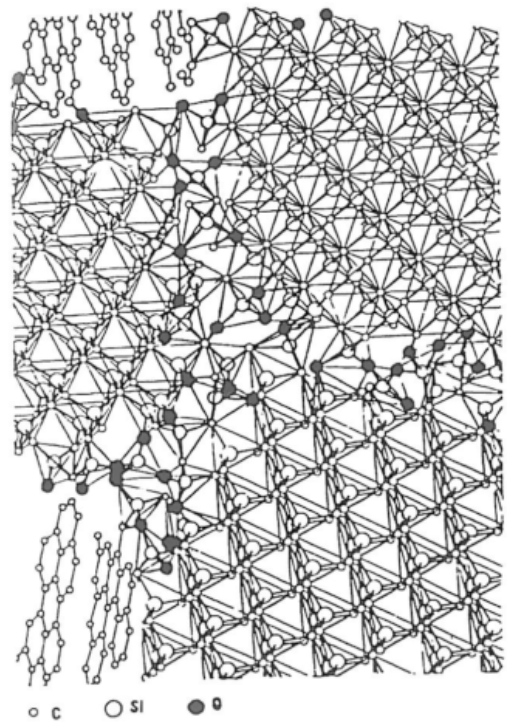
Figure 40. Texture model of the Nicalon NLM-202 fibers. Reprinted with permission from Reference [138]. Copyright 1999 Elsevier.